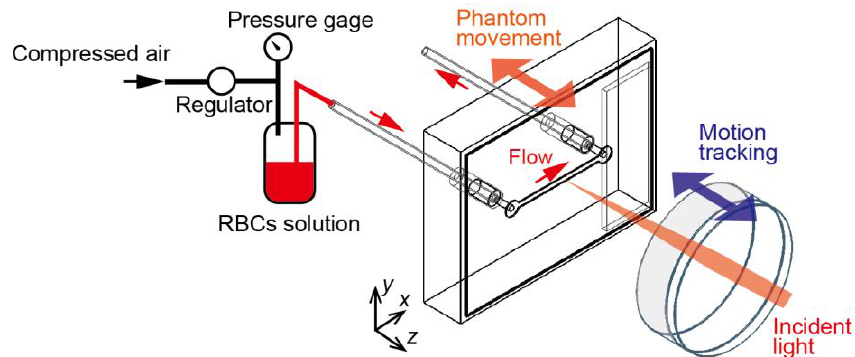
Figure 3. Blood flow in the microfluidic channel and phantom platform movement in the direction of the optical axis. The flow velocity of the RBCs solution in the channel can be controlled by adjusting the pressure. The concentration of the RBC solution (derived from cow hemoglobin) is 20 mg/mL.